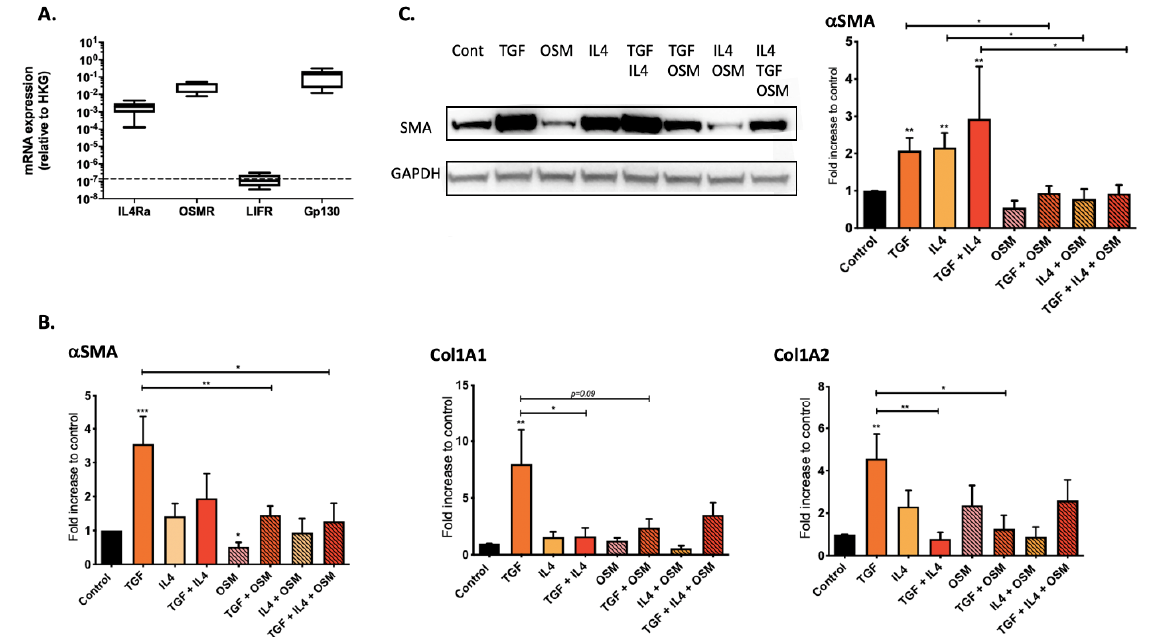
Figure 2. IL-4R α 1, OSMR and gp130, but not LIFR, were expressed in nasal-polyp-derived fibroblasts ( n = 5). Receptors were analyzed by RT-qPCR using GAPDH as housekeeping gene to normalize gene expression ( A ). Extracellular matrix components and α SMA, mRNA and protein relative expression in nasal fibroblasts cultured with TGF- β 1 and/or IL-4 and/or OSM ( n = 7) were analyzed by RT-qPCR ( B ) and Western blot ( C ) using GAPDH as housekeeping gene to normalize gene and protein expression. The y-axis represents the relative expression normalized to housekeeping gene (HKG). The experiment was repeated four times and images are representative of one experiment. Comparisons are made with the control group (single stars) and between groups (bars) * p < 0.05; ** p < 0.01; *** p < 0.001.